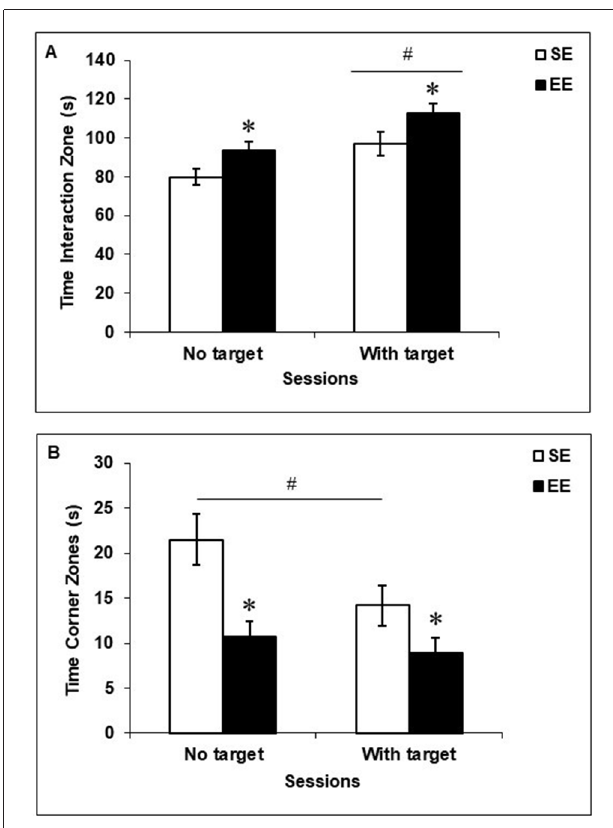
FIGURE 2 | Social behaviors in the social interaction test in mice housed for 6 weeks in a SE or an EE. (A) EE mice spent more time in the Interaction Zone than SE mice, irrespective of whether a mouse target was present in the enclosure ( ∗ p < 0.05 relative to mice housed in SE). Both SE and EE mice spent more time in the Interaction Zone when a mouse target was present ( # p < 0.001 relative to the absence of a mouse target). (B) Mice housed in EE spent less time in the Corner Zones than SE mice, irrespective of whether a mouse target was present in the enclosure ( ∗ p < 0.005 relative to mice housed in SE). Only SE mice spent less time in the Corner Zones in the presence of a mouse target ( # p < 0.05 relative to the absence of a mouse target). Data represents means ± SEM (mice housed in SE: n = 12; mice housed in EE: n = 8).